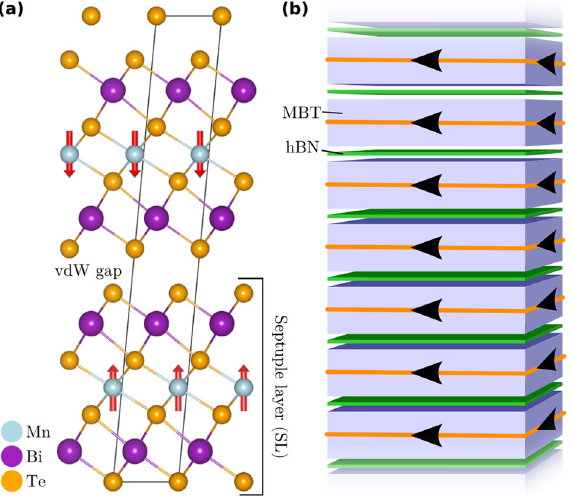
Fig. 1 Bulk MnBi 2 Te 4 structure and schematic of the proposed heterostructure. a Side view of the bulk MnBi 2 Te 4 (MBT) crystal structure. Red arrows denote Mn local moments. b Schematic depiction of the proposed system: MBT fi lms are separated by hBN monolayers to make a vdW multilayer heterostructure with Chern number equal to the number of MBT fi lms, C = n . Black arrows depict the direction of the edge currents.